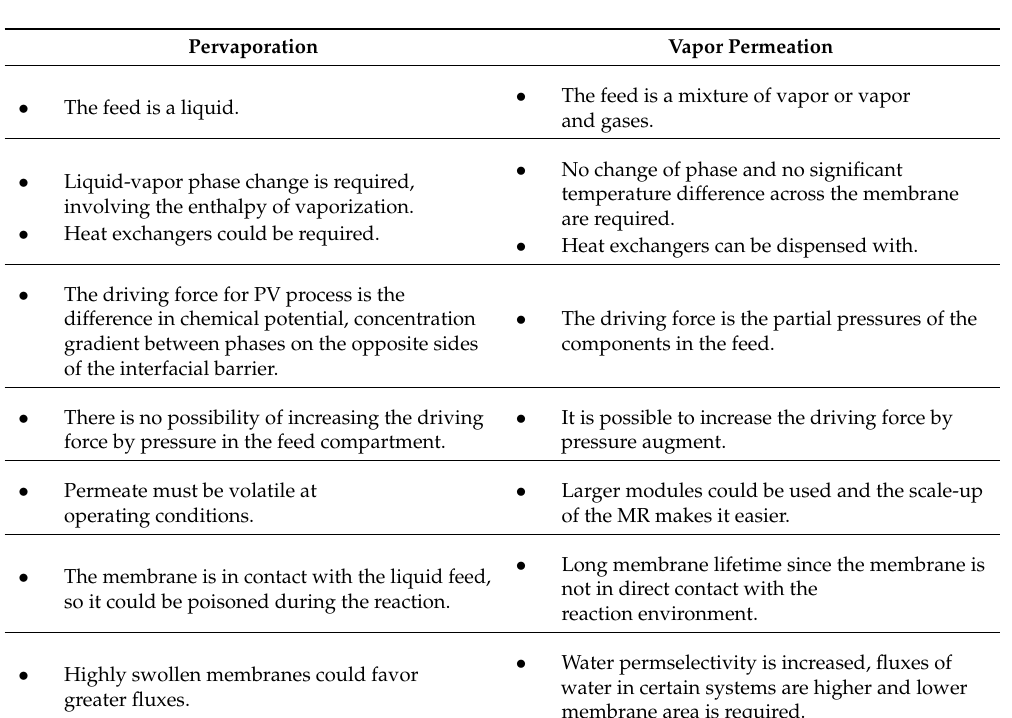
Table 2. Comparison between PV and VP